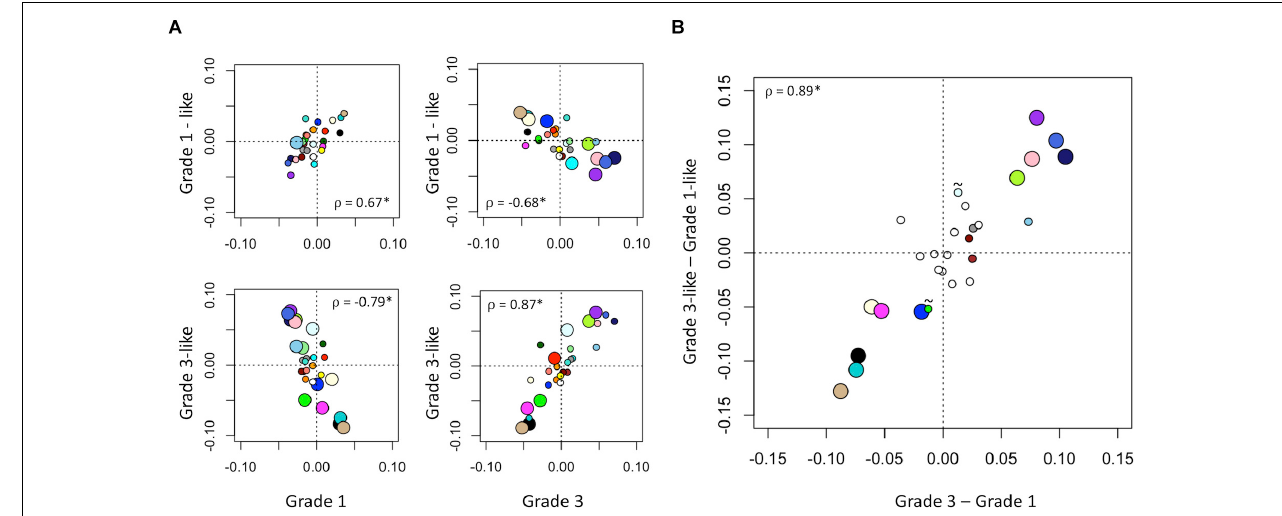
FIGURE 4 | Molecular identity of newly described grade 2 meningioma subgroups. (A) Scatter plot of median module meta-gene expression (unitless). Larger circles indicate Mann–Whitney p < 0.05. Colors correspond to previously identified modules in Figure 1B . ρ = Pearson coefficient, * p < 0.05. Note the positive correlation between the modules of grade 1 and “grade 1-like” and grade 3 and “grade 3-like” subtypes. (B) Scatter plots of genetic separation between grade 2 subtypes as histological grades. The x -axis represents the difference in median module expression between grades 3 and 1, while the y -axis represents the difference in median module expression between “grade 3-like” and “grade 1-like.” Large circles represent modules which are significantly different in both comparisons and empty circles indicate modules which are not significantly different in either. Of the remainder, 4/6 are significantly different between grades 3 and 1 only and 2/6 is significantly different between “grade 3-like” and “grade 1-like” ( ∼